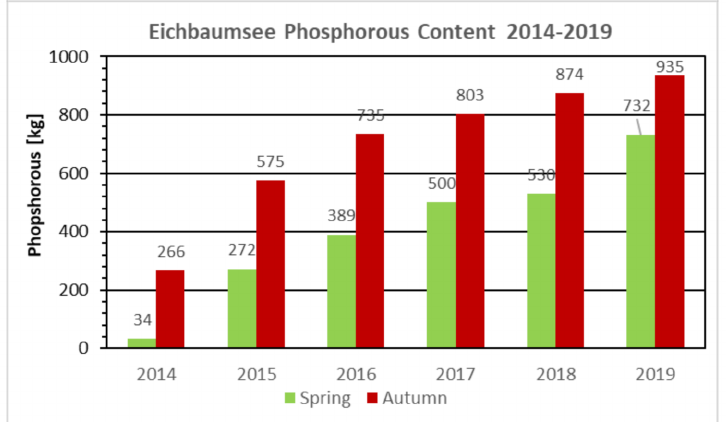
Figure 15. Phosphorous contents of waters in Lake Eichbaumsee between spring 2014 and autumn 2019. Numbers give the phosphorous content in kg. Data are from [28,29,40] and this